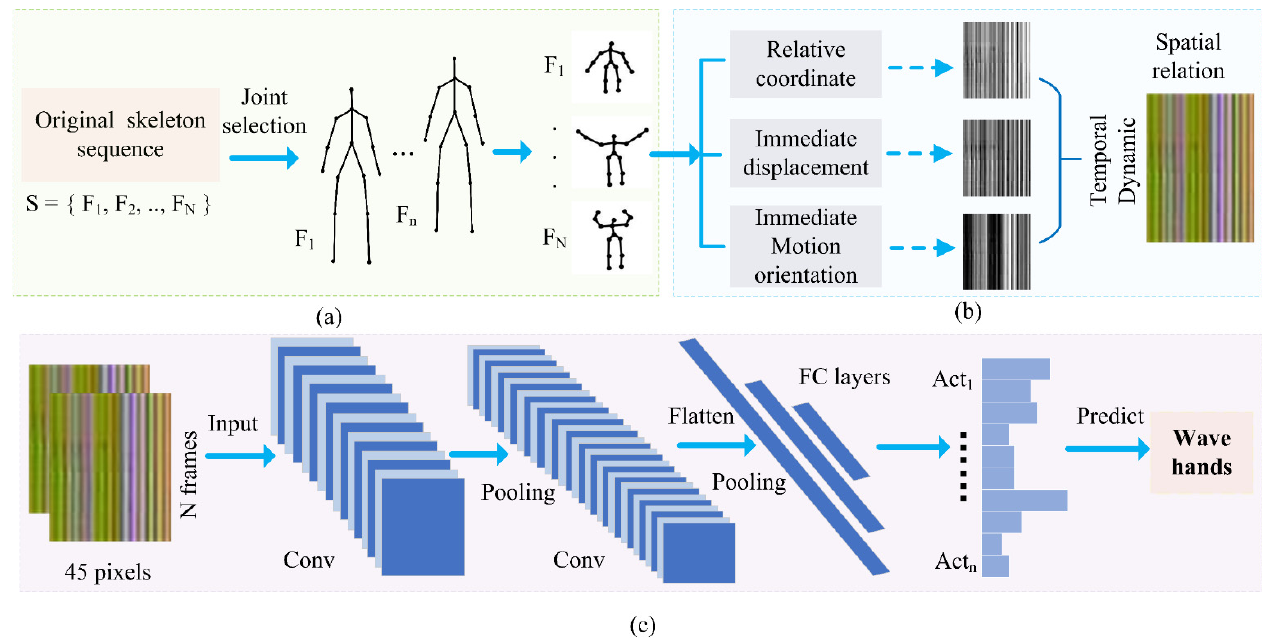
Figure 1. The overall flowchart of our method for action recognition. ( a ) Extract 15 joints for each original skeleton sequence, and a data augmentation strategy is proposed to enlarge training samples and prevent overfitting. ( b ) Calculate three relative features to represent human actions and then encode these features into a color image. ( c ) Input the generated motion images into a shallow CNN model for HAR.